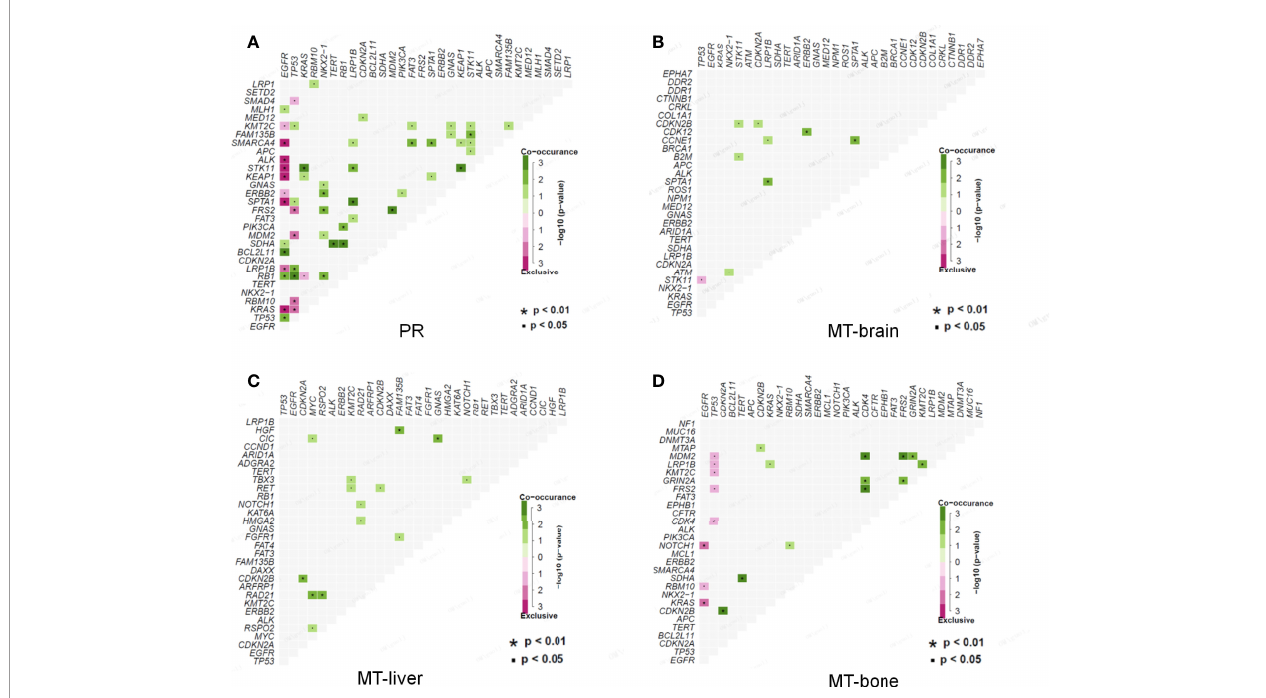
FIGURE 5 | Co-occurrence of genomic alterations in PR and metastases. (A) The co-occurrence relationship between genomic mutations in PR is displayed in heatmap. (B – D) The co-occurrence relationships between genomic mutations in MT-brain, MT-liver, and MT-bone are shown in corresponding heatmaps,